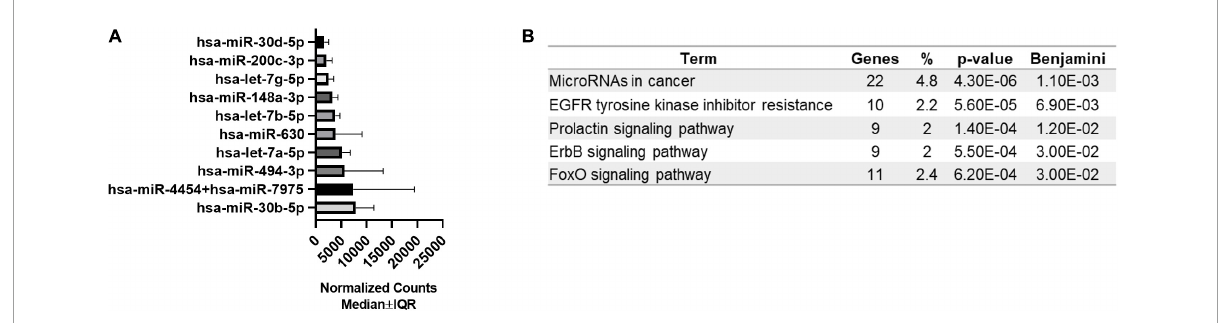
FIGURE2 Top 10 most abundant miRNAs in bEVs and enriched pathways of target genes. (A) The top 10 most abundant miRNAs were identified using normalized median counts ( n = 65). (B) Enriched pathways of target genes of the top 10 miRNAs of bEVs are